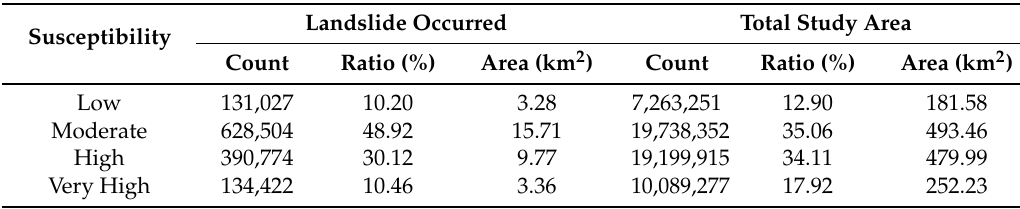
Table 5. Statistical results of LSM in the Xulong hydropower station